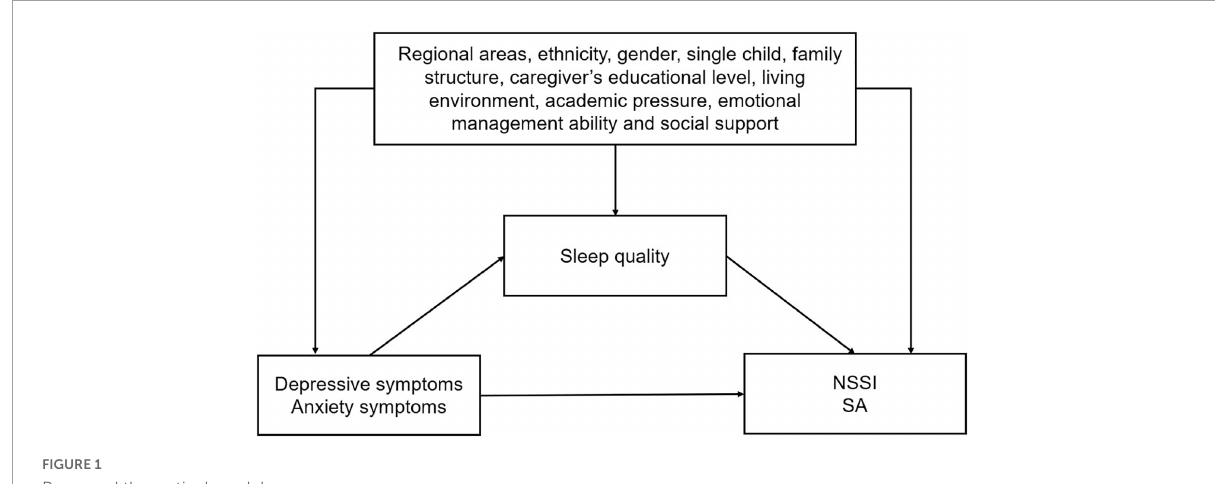
FIGURE1 Proposed theoretical model.